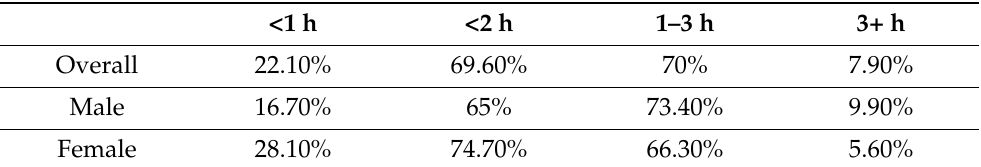
Table 1. Percentage of participants across range of screen time